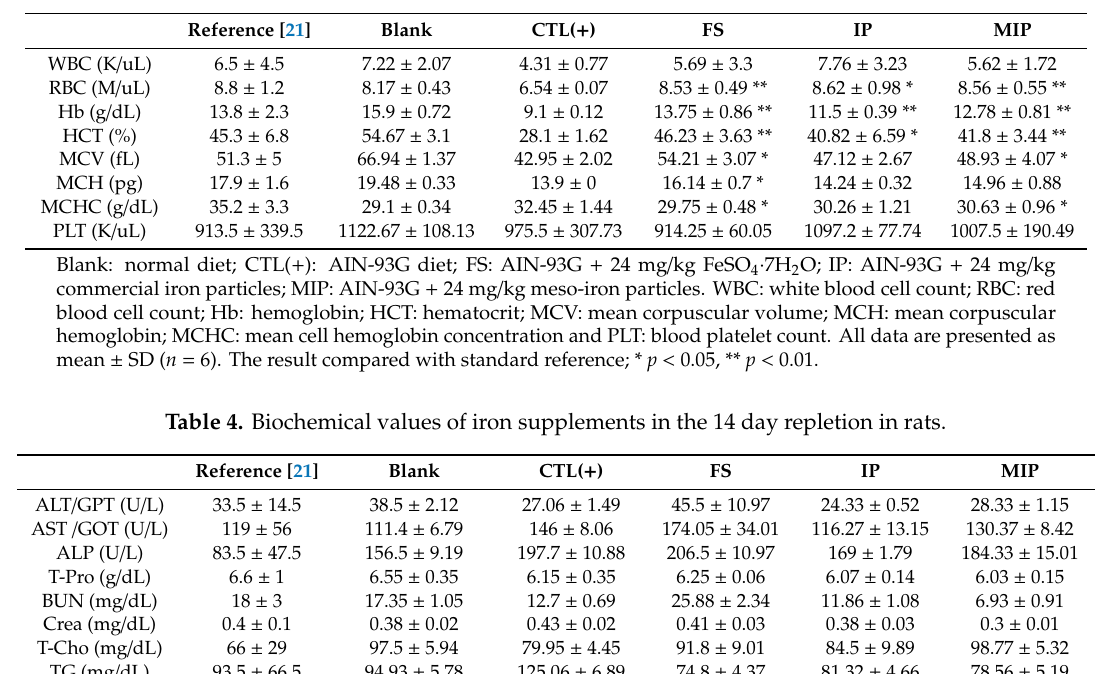
Table 3. Hematology values of iron supplements after 14 day repletion in rats.